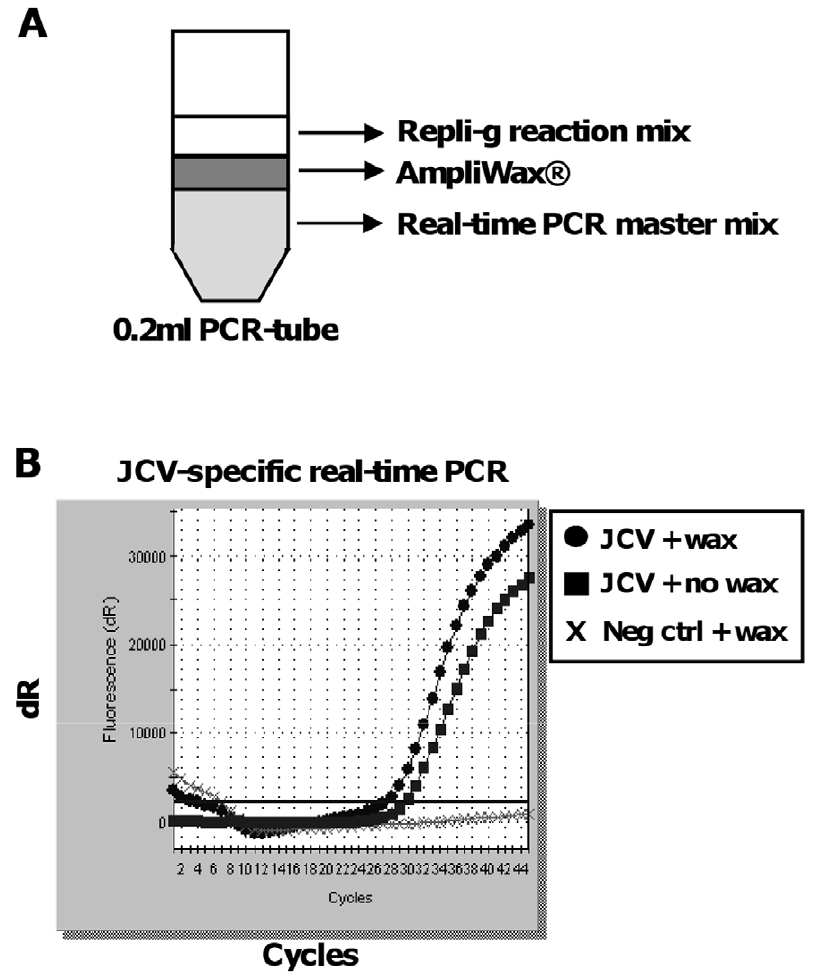
Figure 1. Description of the Amp-PCR method. In Amp-PCR a random pre-amplification step is combined with a specific real-time PCR and the two reactions performed in sequel in the same closed tube. A physical barrier is created between the two reactions by the use of an AmpliWax H -layer. The Phi29-based pre-amplification (Repli-g) is performed first at 30 u C, followed by 95 u C to inactivate Phi29 plus activate the Taq enzyme and to melt the wax, and finally the specific real-time PCR is performed. (A) Schematic picture of the Amp-PCR reaction in a 0.2 ml PCR-tube, including the Repli-g reaction, the AmpliWax H -seal and the specific real-time PCR reaction. (B) JCV-specific real-time PCR with or without AmpliWax H , which do not interfere with the JCV-specific PCR reaction. Negative control is